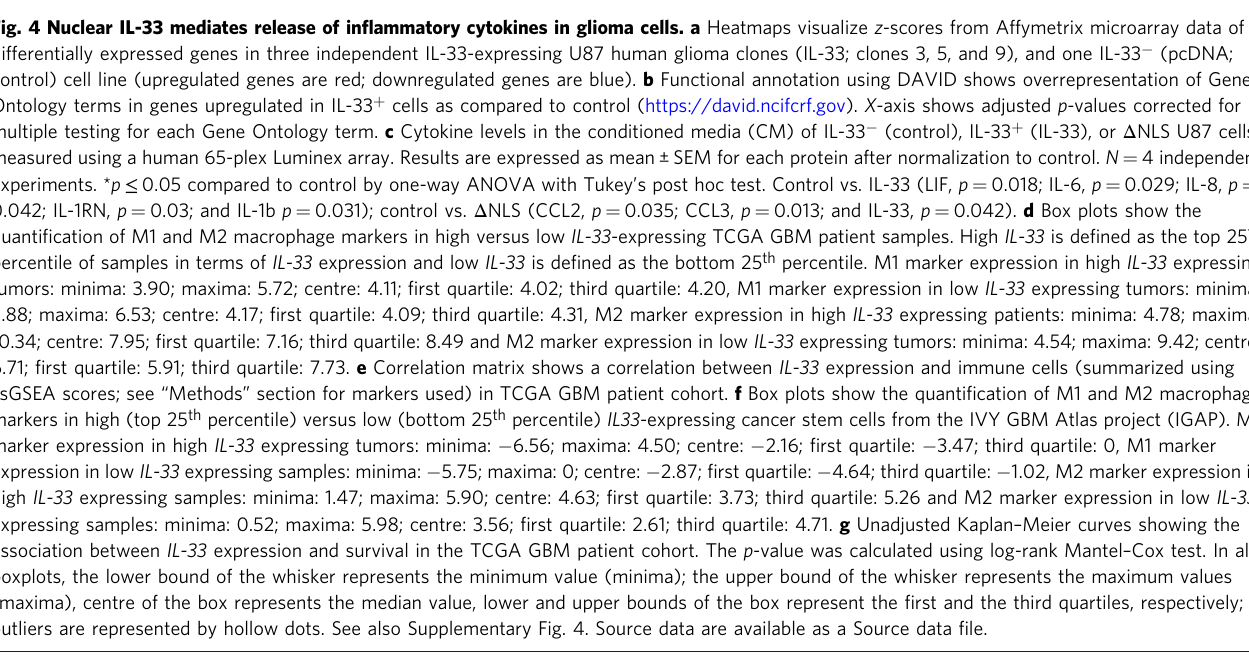
Fig. 4 Nuclear IL-33 mediates release of in fl ammatory cytokines in glioma cells. a Heatmaps visualize z -scores from Affymetrix microarray data of differentially expressed genes in three independent IL-33-expressing U87 human glioma clones (IL-33; clones 3, 5, and 9), and one IL-33 − (pcDNA; control) cell line (upregulated genes are red; downregulated genes are blue). b Functional annotation using DAVID shows overrepresentation of Gene Ontology terms in genes upregulated in IL-33 + cells as compared to control (https://david.ncifcrf.gov). X -axis shows adjusted p -values corrected for multiple testing for each Gene Ontology term. c Cytokine levels in the conditioned media (CM) of IL-33 − (control), IL-33 + (IL-33), or Δ NLS U87 cells measured using a human 65-plex Luminex array. Results are expressed as mean ± SEM for each protein after normalization to control. N = 4 independent experiments. * p ≤ 0.05 compared to control by one-way ANOVA with Tukey ’ s post hoc test. Control vs. IL-33 (LIF, p = 0.018; IL-6, p = 0.029; IL-8, p = 0.042; IL-1RN, p = 0.03; and IL-1b p = 0.031); control vs. Δ NLS (CCL2, p = 0.035; CCL3, p = 0.013; and IL-33, p = 0.042). d Box plots show the quanti fi cation of M1 and M2 macrophage markers in high versus low IL-33 -expressing TCGA GBM patient samples. High IL-33 is de fi ned as the top 25 th percentile of samples in terms of IL-33 expression and low IL-33 is de fi ned as the bottom 25 th percentile. M1 marker expression in high IL-33